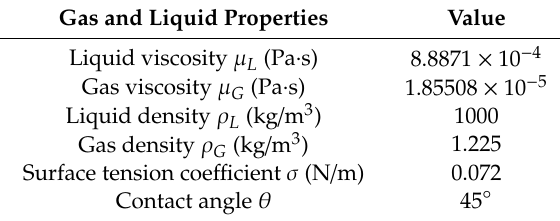
Table 1. Gas and liquid properties employed in both verify and DEM-CFD simulations.